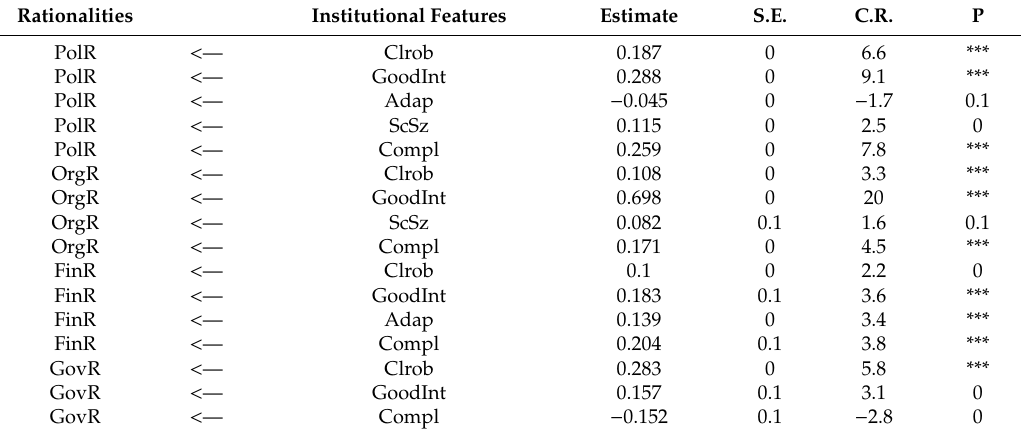
Table 5. Institutional features and rationalities (Pathways 1–2